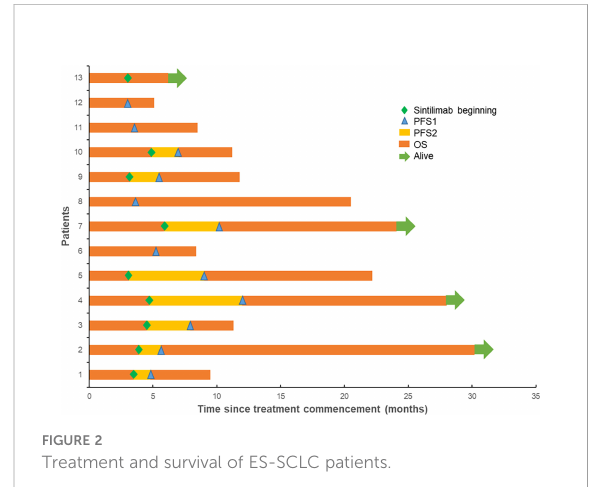
FIGURE 2 Treatment and survival of ES-SCLC